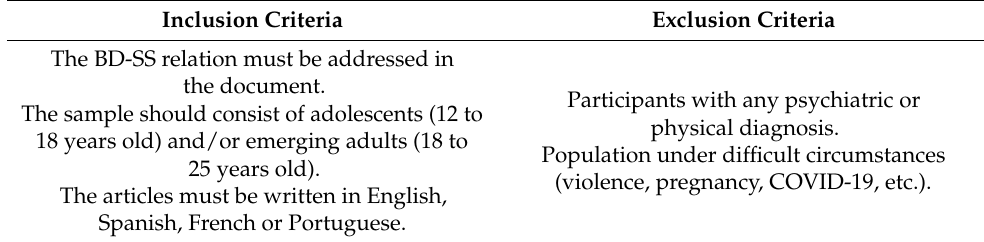
Table 1. Eligibility Criteria for the Screening of